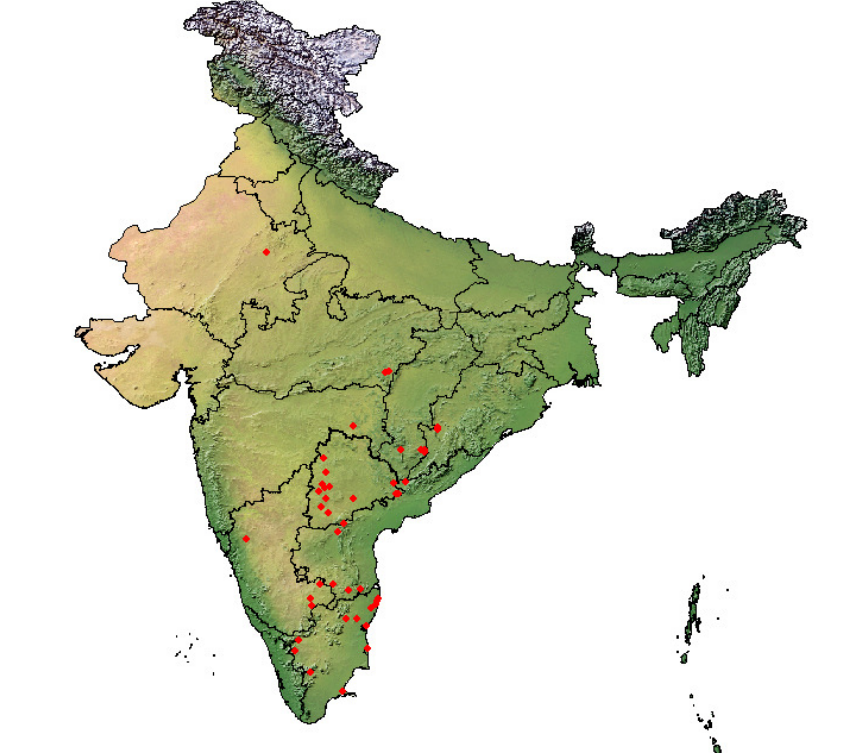
Figure 4. Distribution of Gigantometrus swammerdami (Simon, 1872) in